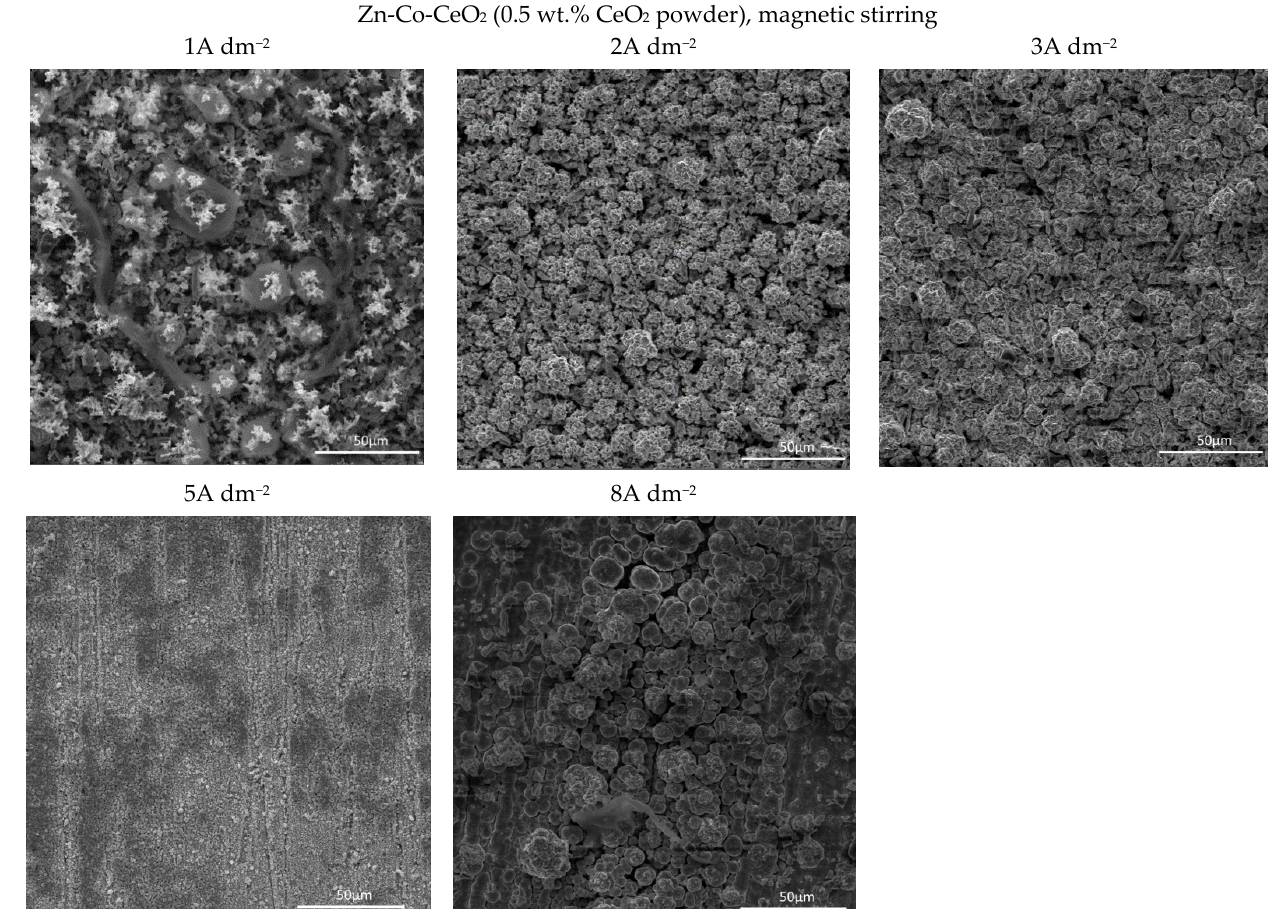
Figure 6. Morphology of the Zn-Co-CeO 2 composite coatings deposited at different current densities from the plating solution with 0.5 wt.% ceria powder.